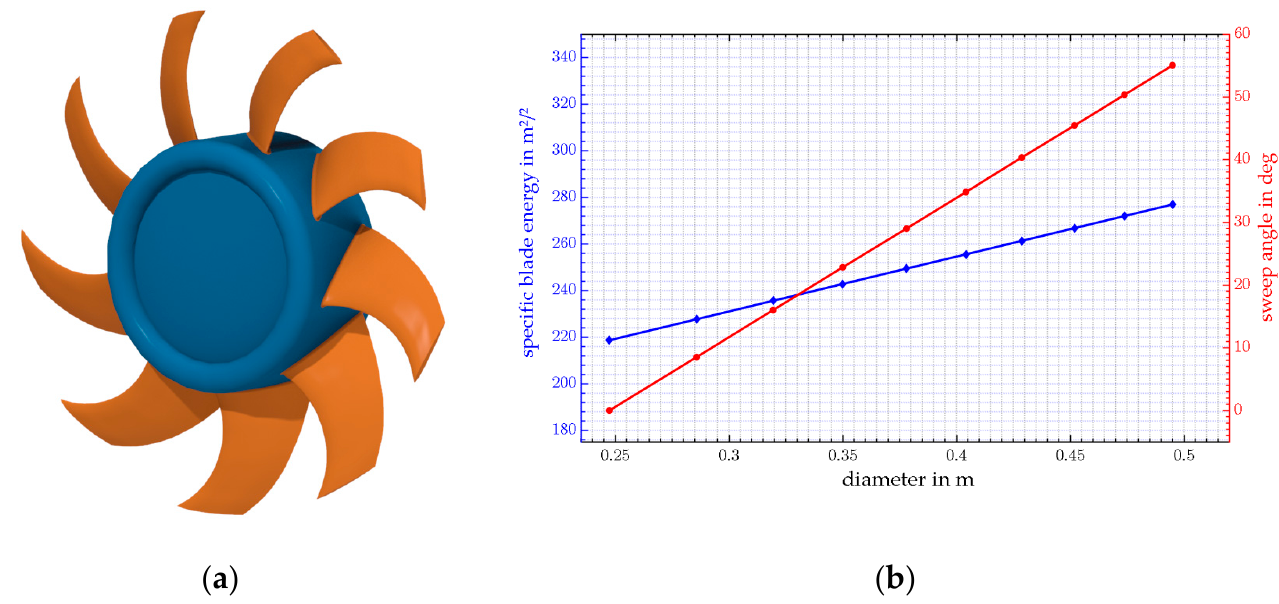
Figure 1. Investigated axial fan and its characteristics. ( a ) CAD representations of the nine bladed forward-skewed axial fan used, and ( b ) the specific blade energy and sweep angle.